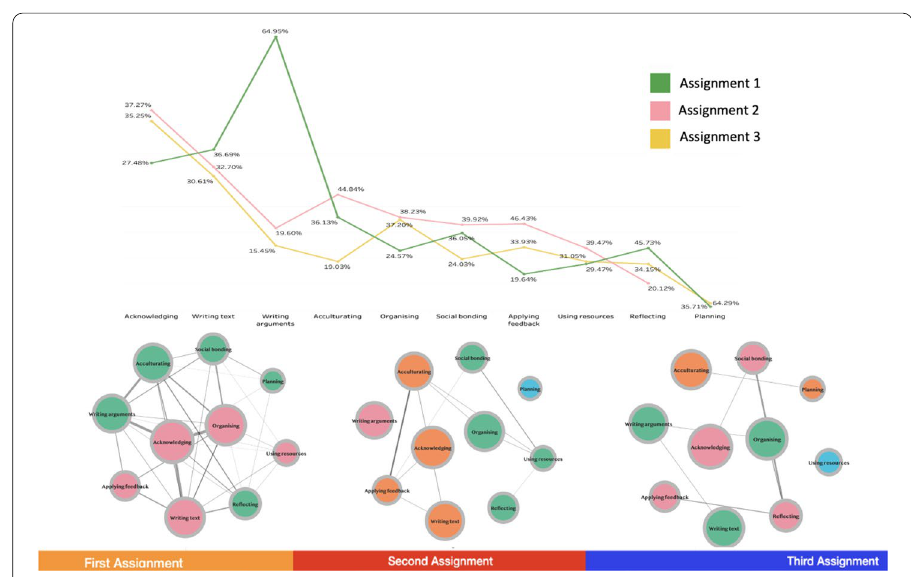
Fig. 2 A Frequency plot of students’ use of SRL tactics during the three assignment phases and three network graphs on the links between students’ SRL tactics for each assignment. Nodes with similar colours occur more frequently